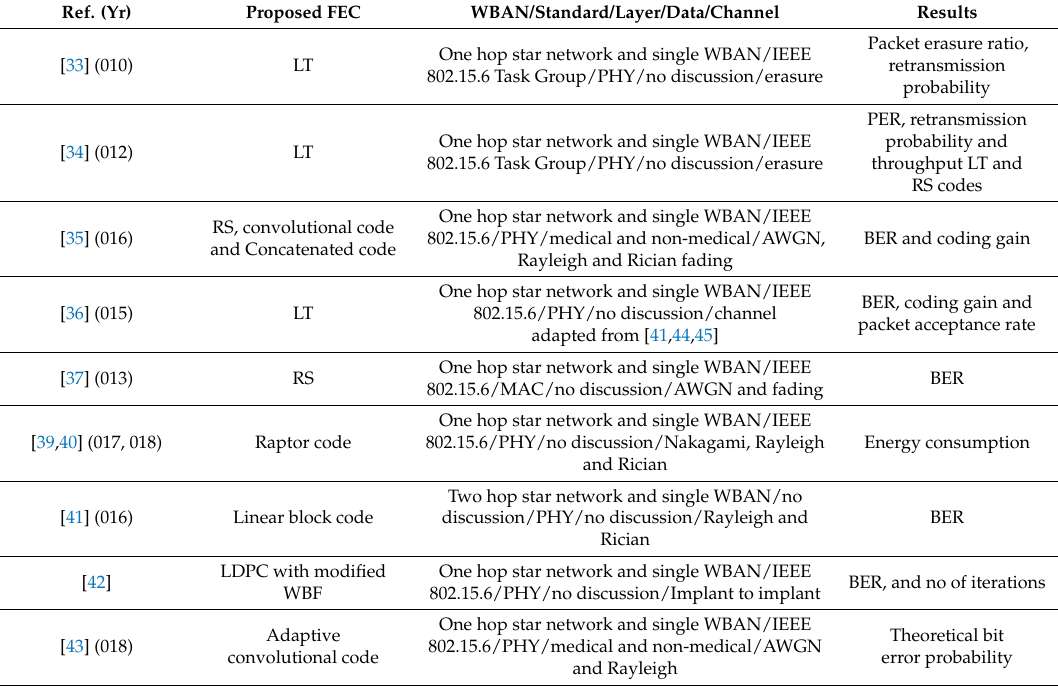
Table 5. A review of forward error correction (FEC) based